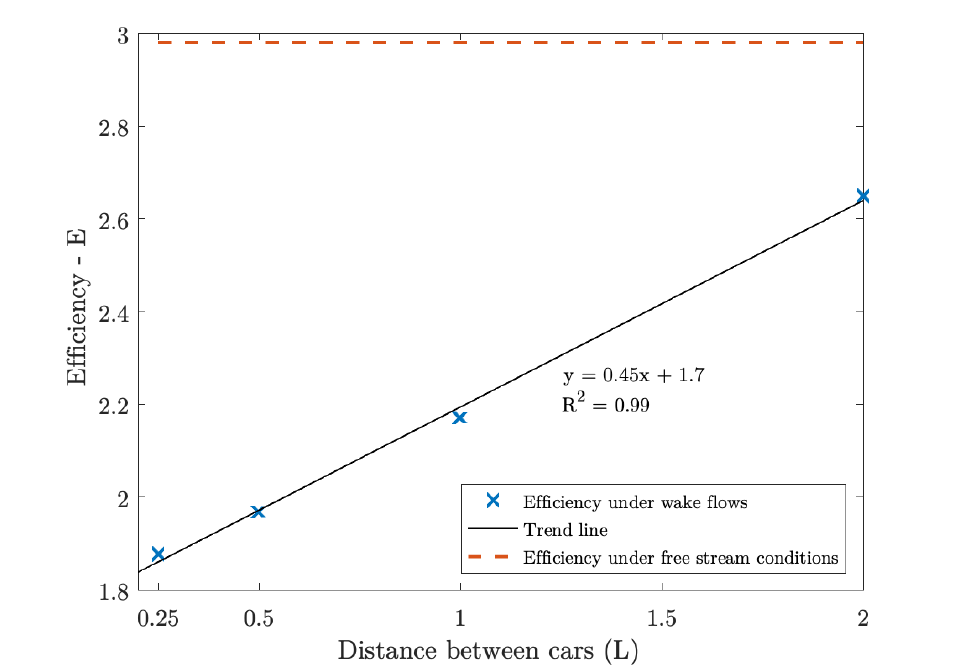
Figure 14. Comparison between values of efficiency under wake flows and under free stream